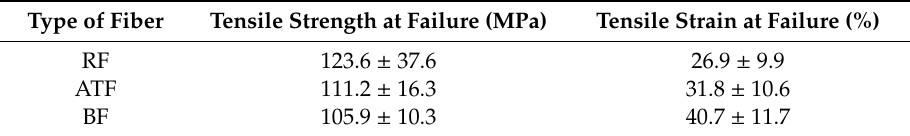
Table 4. Tensile strengths and tensile strains of coconut fibers.